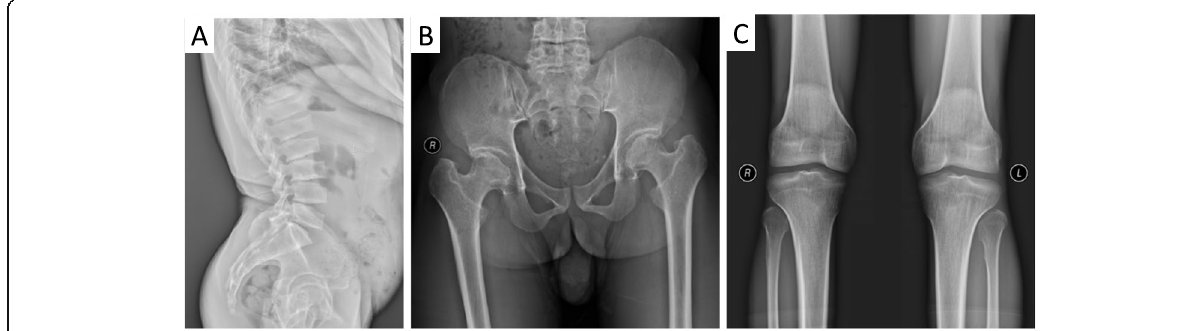
Fig. 2 X-ray radiographs of the proband. a , the radiograph of the lateral lumbosacral spine showed platyspondyly and dysplasia with posterior humping. b , the radiograph of the hips showed flattened femoral heads, narrow hip-joint surfaces, and osteosclerosis of the pelvis. c , the radiograph of the knees displayed flattened tibial plateaus and irregular surface of lateral femur